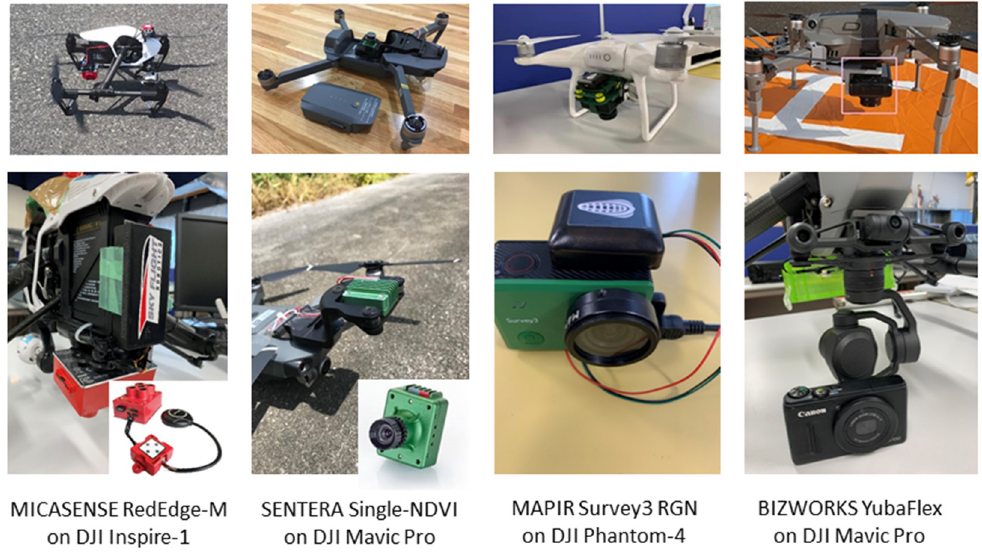
Figure 3. Multispectral cameras used for this analysis.